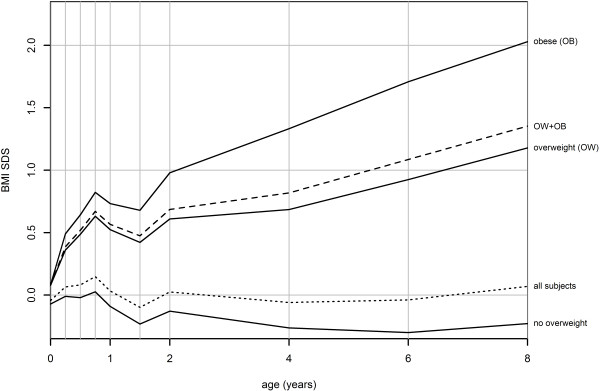
Trajectories of mean BMI SDS values at target ages according to IOTF BMI status at age 8 years (the “broken stick” model). The different lines represent the mean BMI SDS in children with no overweight in the total population; those being overweight (but not obese); those being overweight (OW); being overweight and obese (OW + OB) and being obese (OB) at 8 years of age (N = 3172).